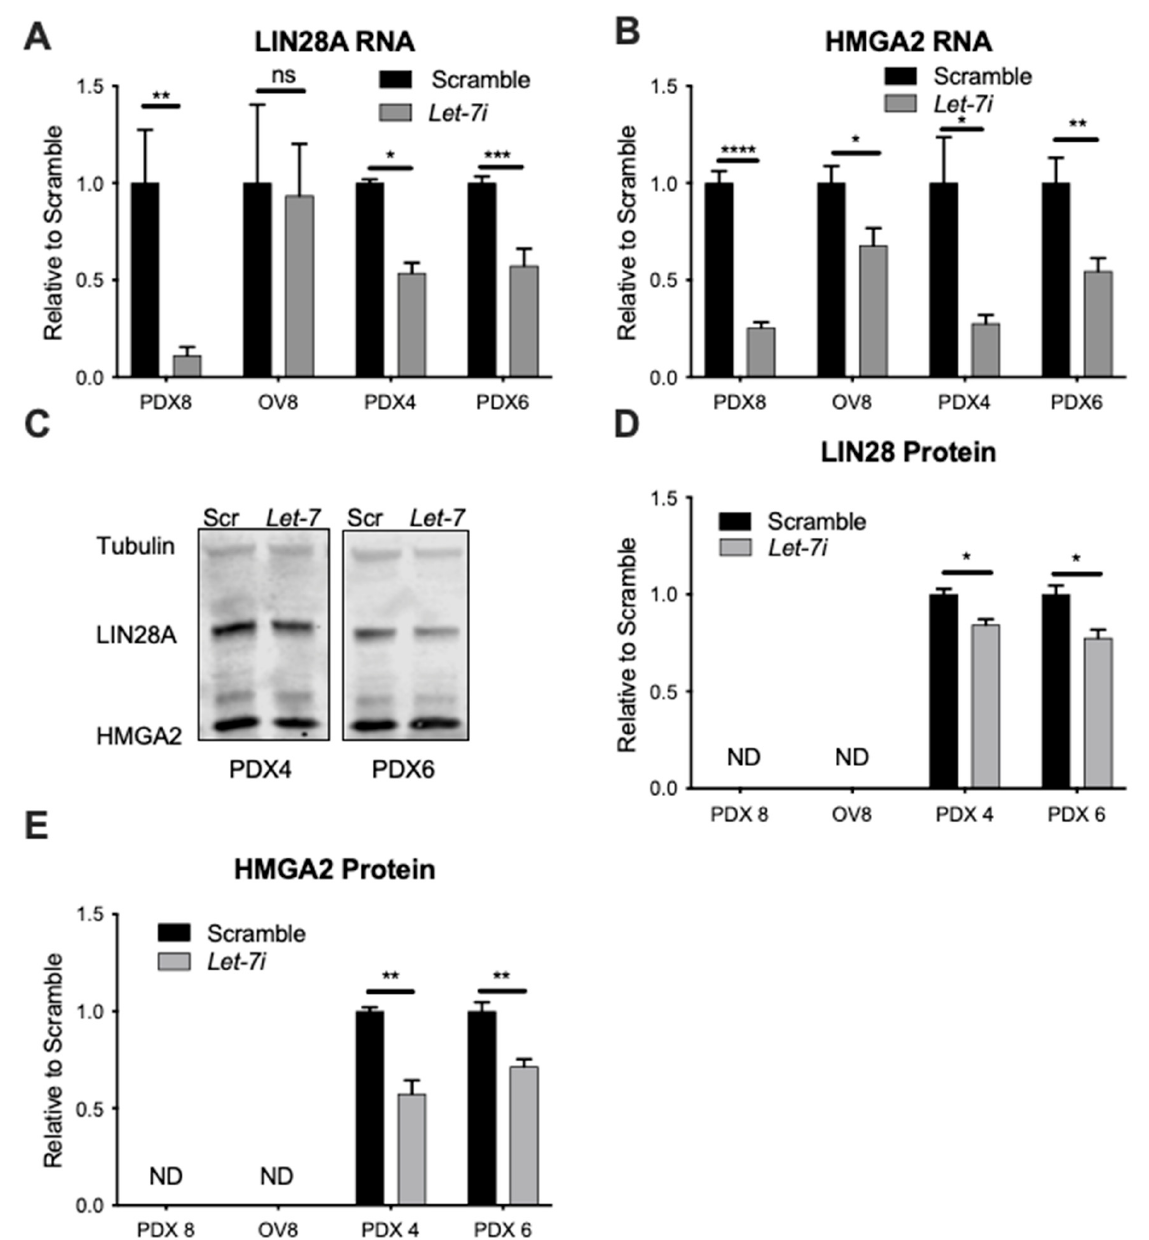
Figure 1. Let-7i up-regulation results in target repression. Let-7i mimic transfection resulted in repression of its targets LIN28A and/or HMGA2 on RNA ( A , B ) and protein ( C ) level, quantified in ( D , E ). LIN28A and HMGA2 protein levels were not detected (ND) in PDX8 and OVCAR8 samples due to very low expression. Student’s t test was used for statistical analysis. N = 3+ independent replicates. Error bars: standard error of the means (SEM). * p ≤ 0.05, ** p ≤ 0.01, *** p ≤ 0.001, **** p ≤ 0.0001. p Value ≤ 0.05 was considered significant. ns, not significant.